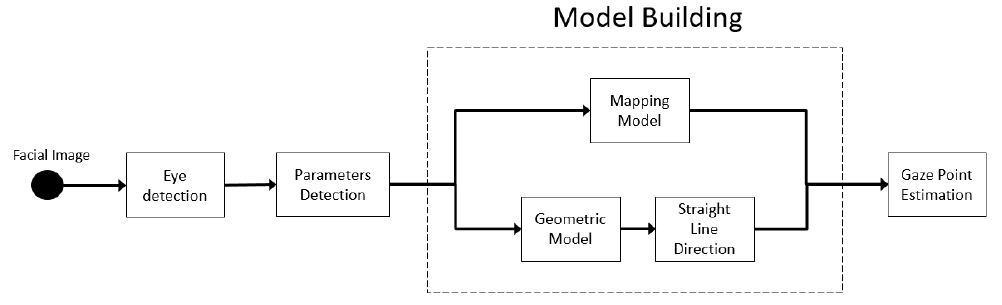
Figure 5. A block diagram of a typical gaze tracking solution from the analysis of the eye/face.